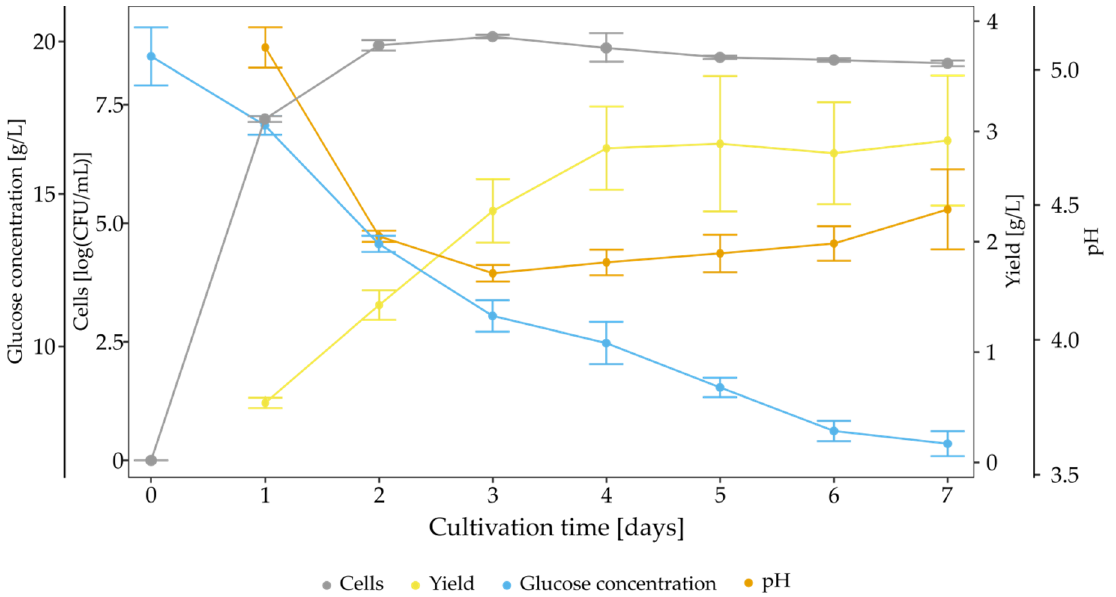
Figure 3. Time course of K. hansenii SI1 growth in SH medium.